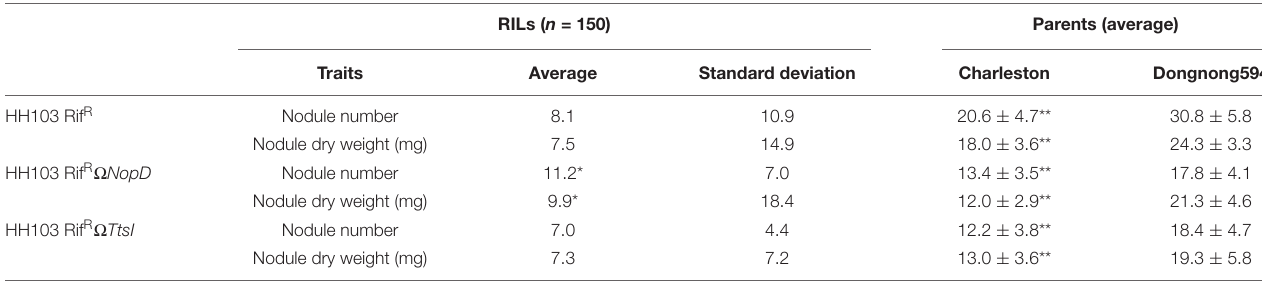
*Indicates significant differences with different inoculations, p ≤ 0.05, **indicates p ≤